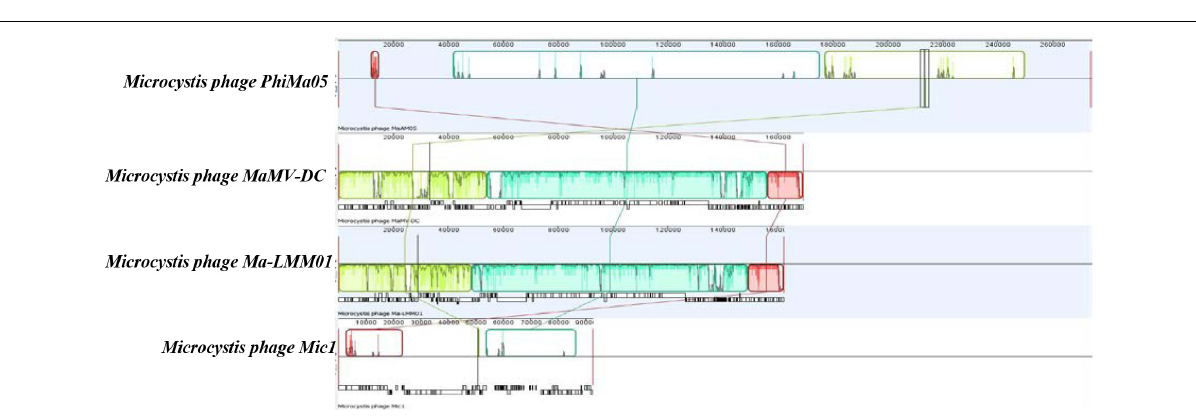
Frontiers in Microbiology |